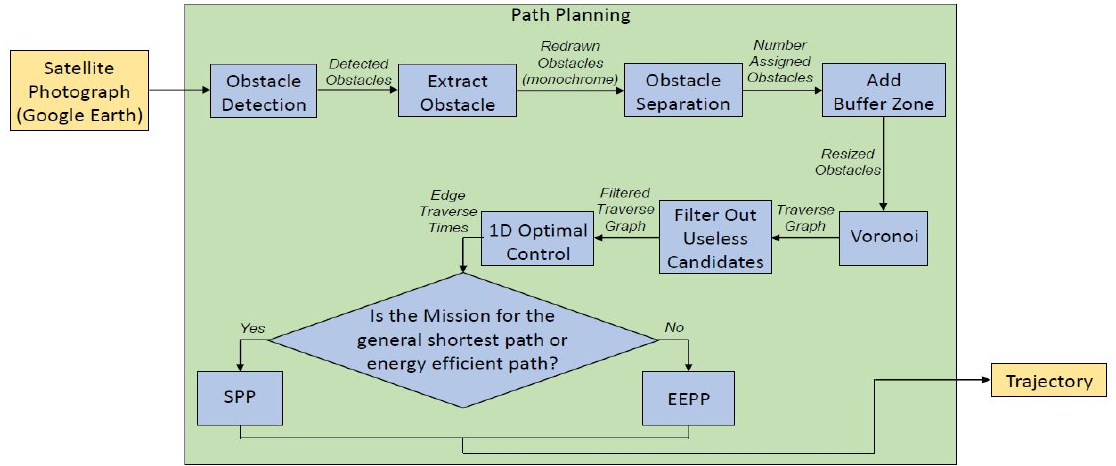
Figure 2. Flowchart of path planning.